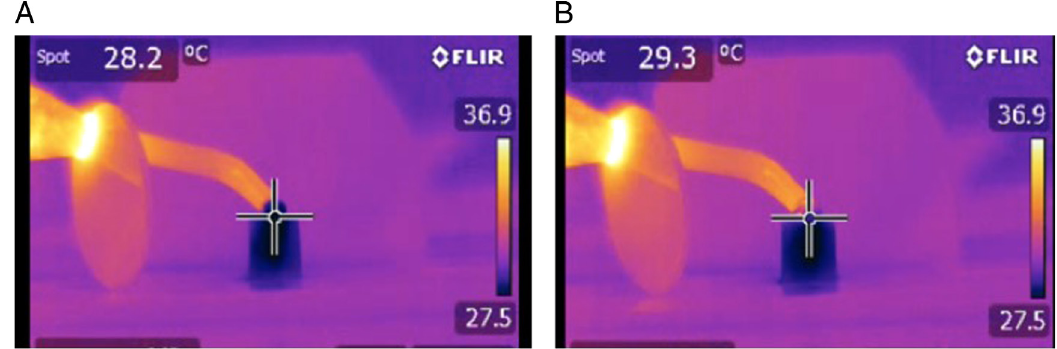
Figure 3. Thermal camera images at the (A) beginning and (B) end of curing.